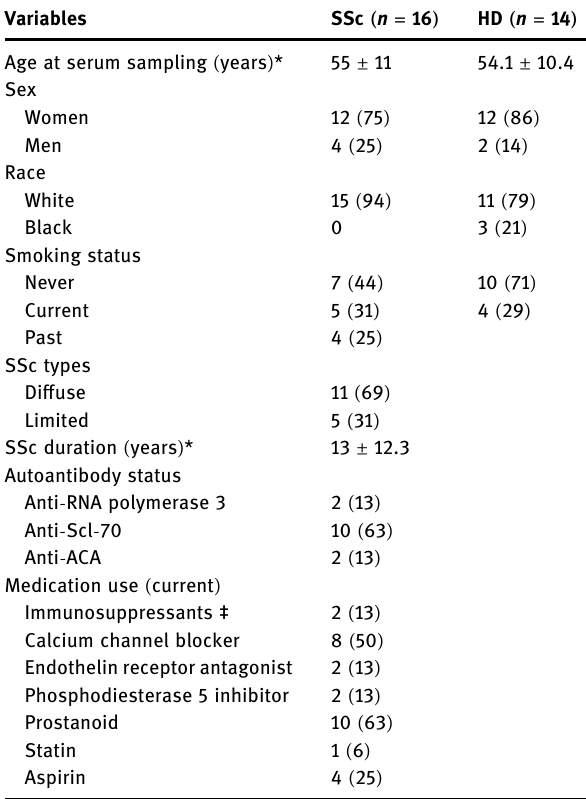
Table 1: Clinical characterization of the enrolled SSc patients